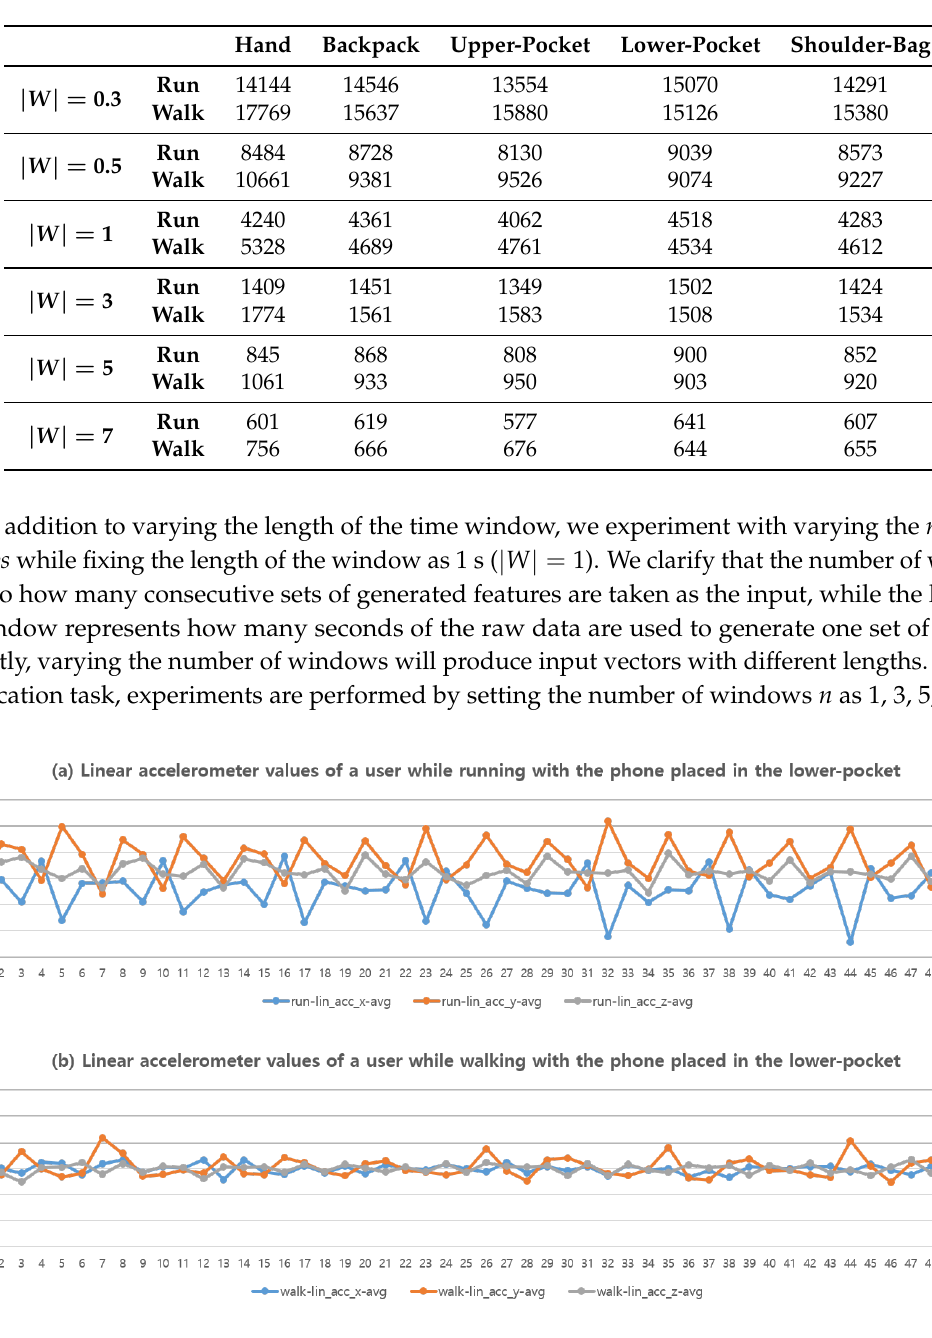
Figure 4. Linear accelerometer values of a user while ( a ) running and ( b ) walking with the phone placed in the